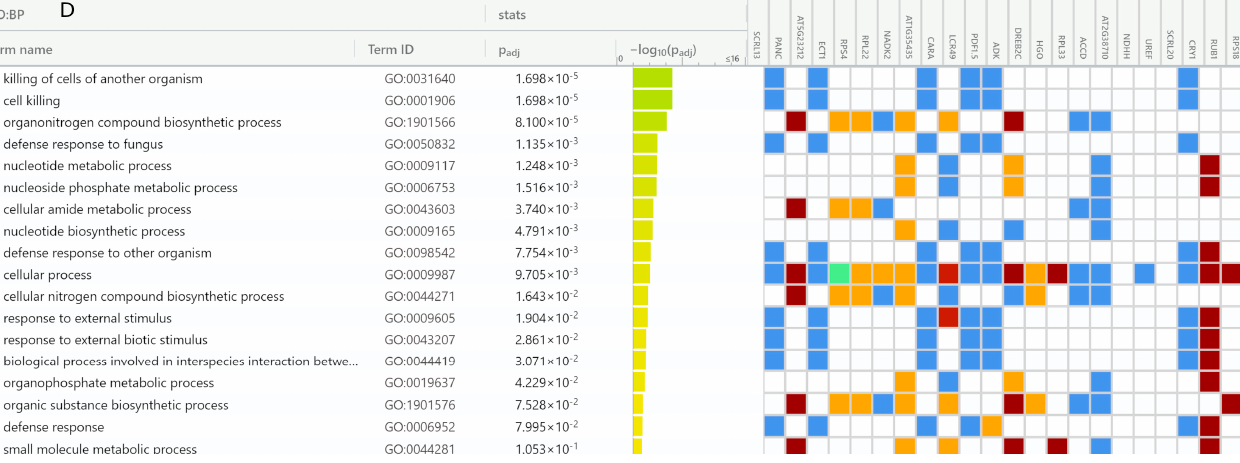
Figure 8. H. sapiens and A. thaliana gene set enrichment analysis of AFP 14–20 -like motif-containing proteins. Human genes categorized in ( A ) molecular function terms and ( B ) biological process terms. A. thaliana genes categorized in ( C ) molecular function terms and ( D ) biological process